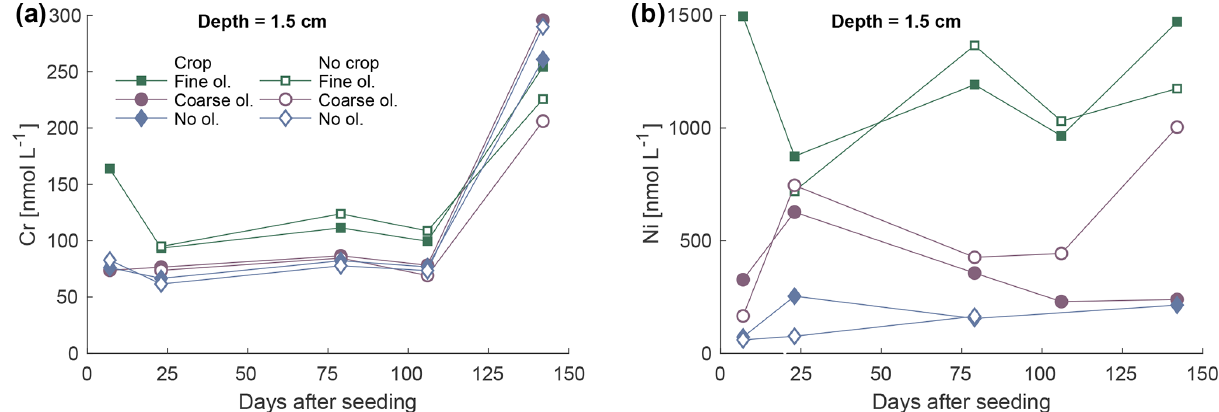
Figure 9. Development of Cr (a) and Ni (b) concentrations in soil pore water over the first 5 months in the layer 1.5cm below the surface, differentiated by olivine and crop treatment. For more data and error bars, please refer to Figs. S9-1 and